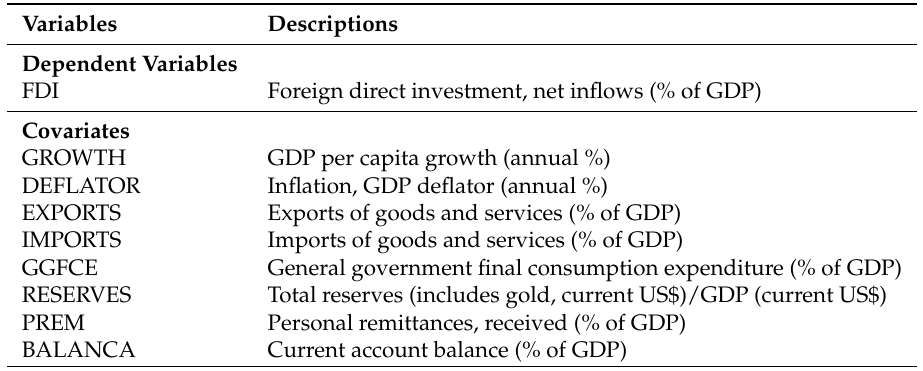
Table 2. Descriptions of